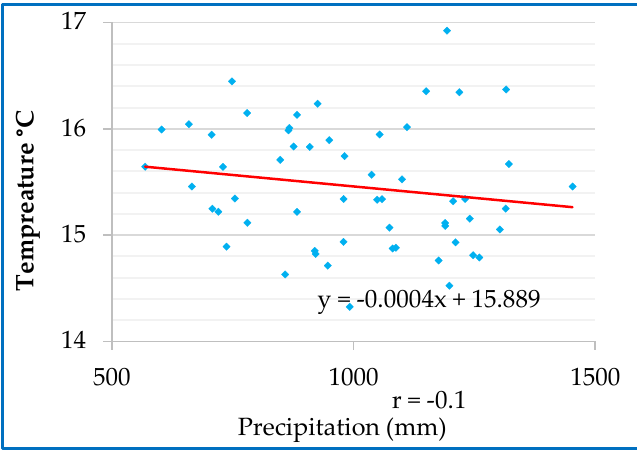
Figure 10. Correlation between precipitation and temperature.